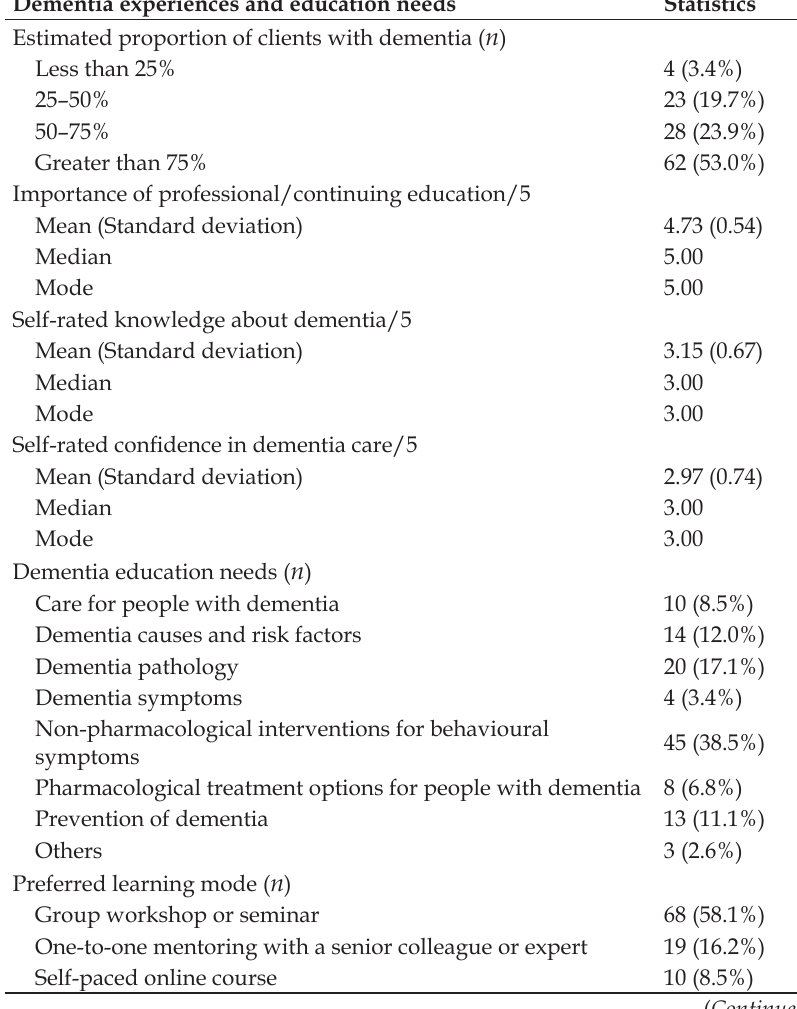
Table 2. Dementia experiences and education needs ( N = 117) Dementia experiences and education needs